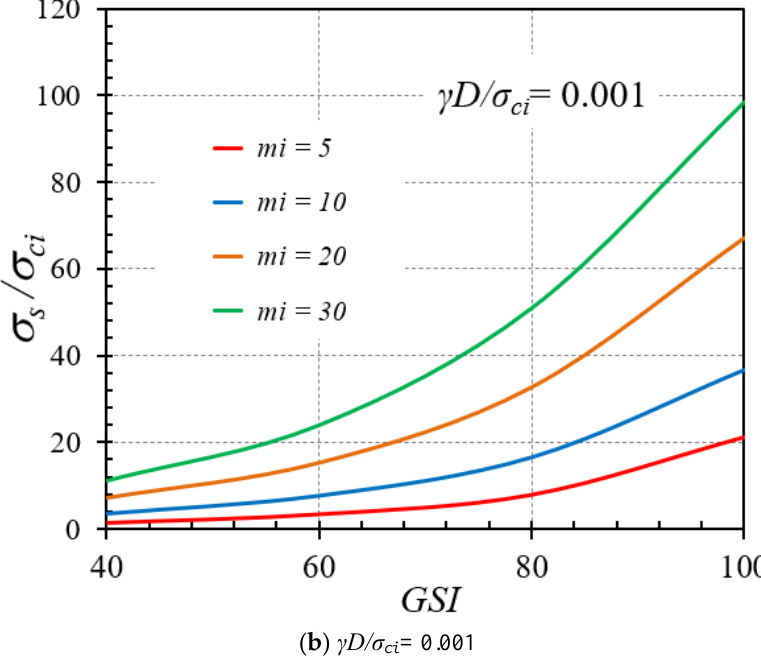
Figure 12. Impact of GSI on the stability solutions of tunnel headings ( C/D = 5 and P/D = 0).